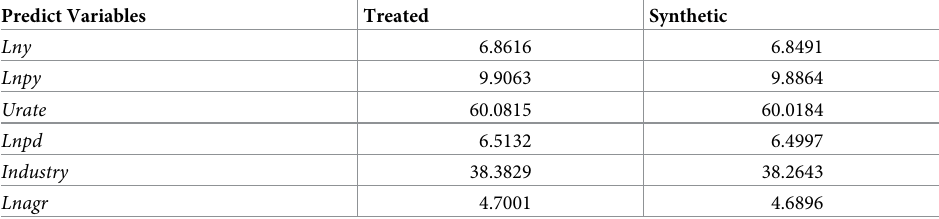
Note: “Treated” represents the treatment group, and “Synthetic” represents the synthetic control